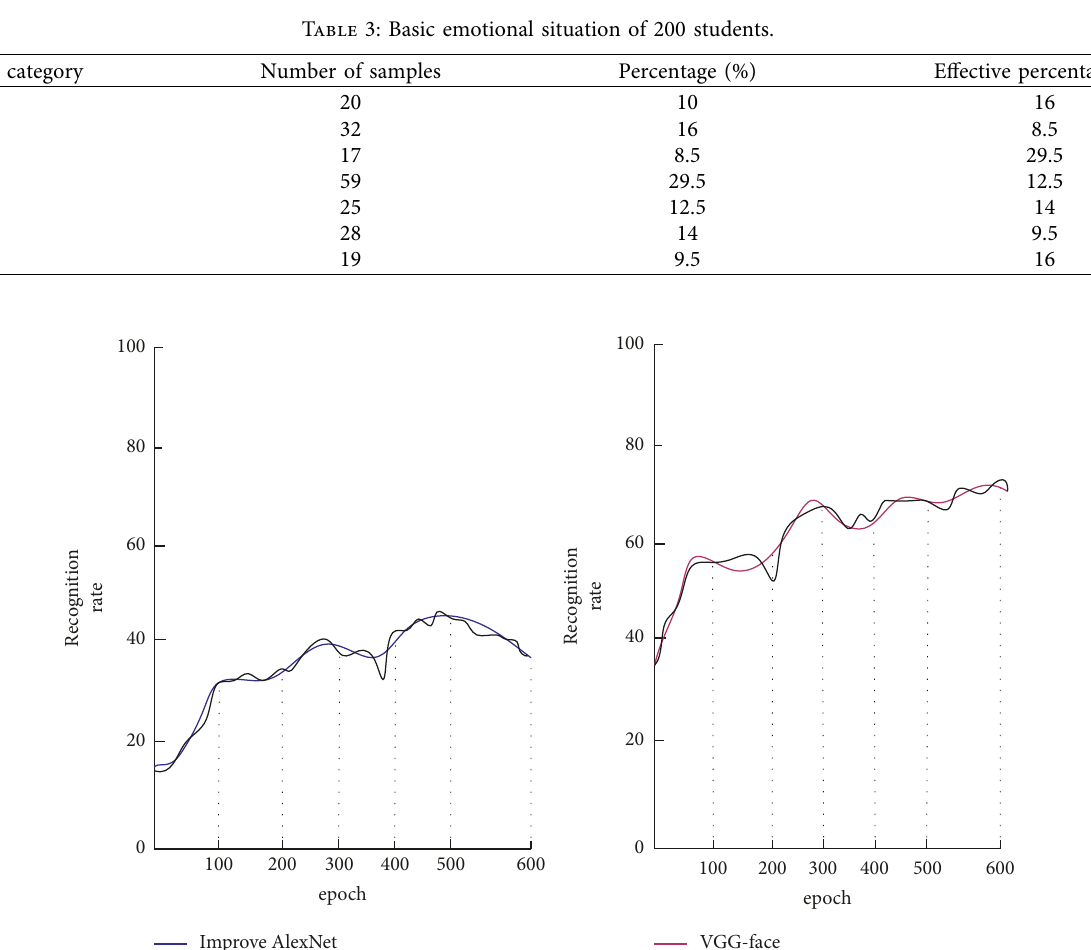
Figure 7: Two methods identify rate